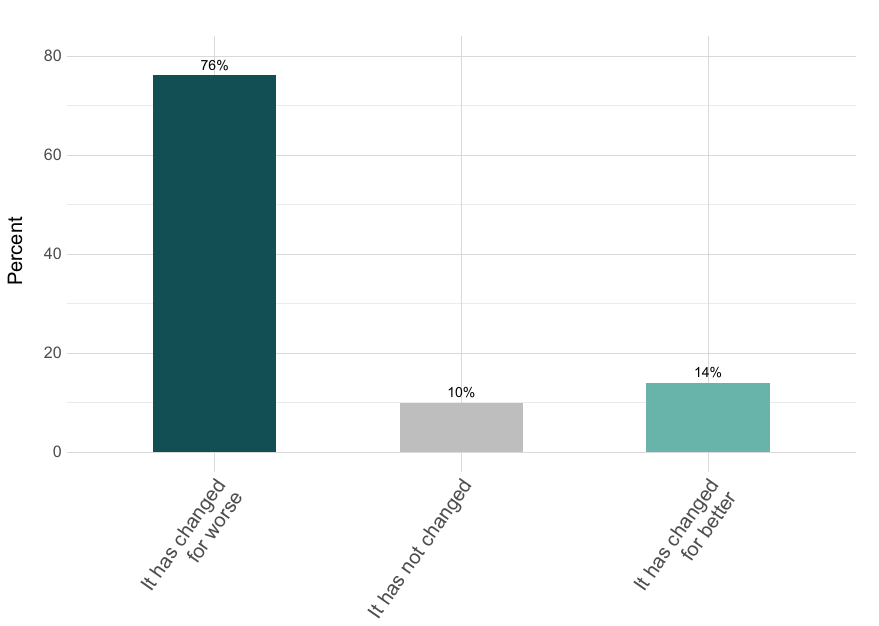
Figure 5. Mental wellbeing in the pandemic relative to pre-pandemic. Answers including “significantly” and “slightly” for both “worse” and “better” were